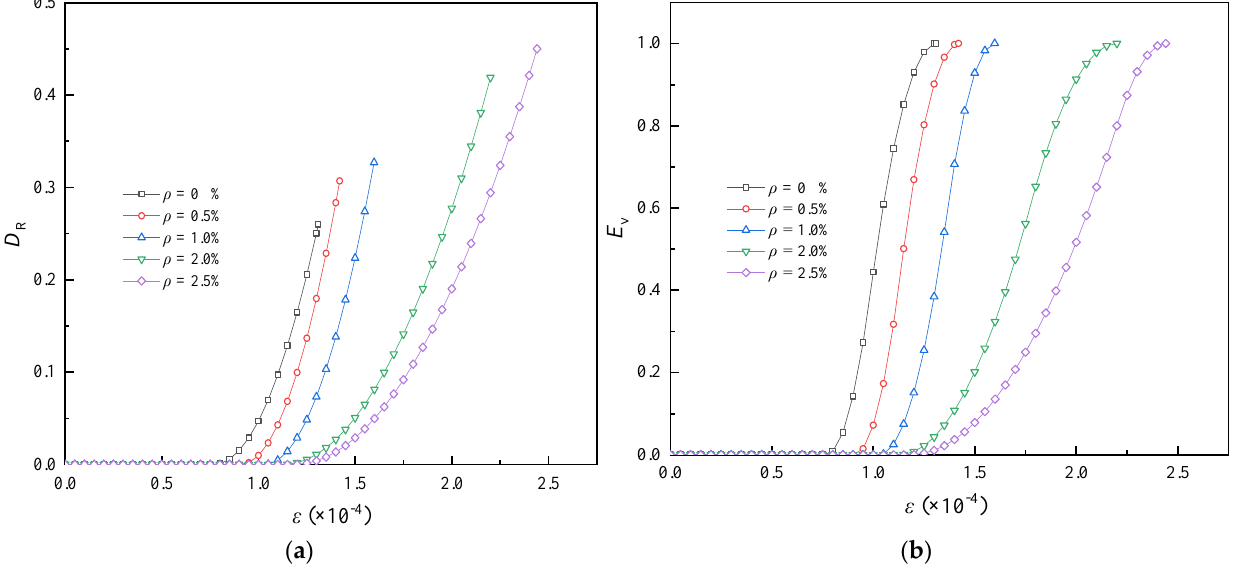
Figure 9. Evolution curves of damage variable and evolution factor: ( a ) D R - ε curves; ( b ) E v - ε curves.